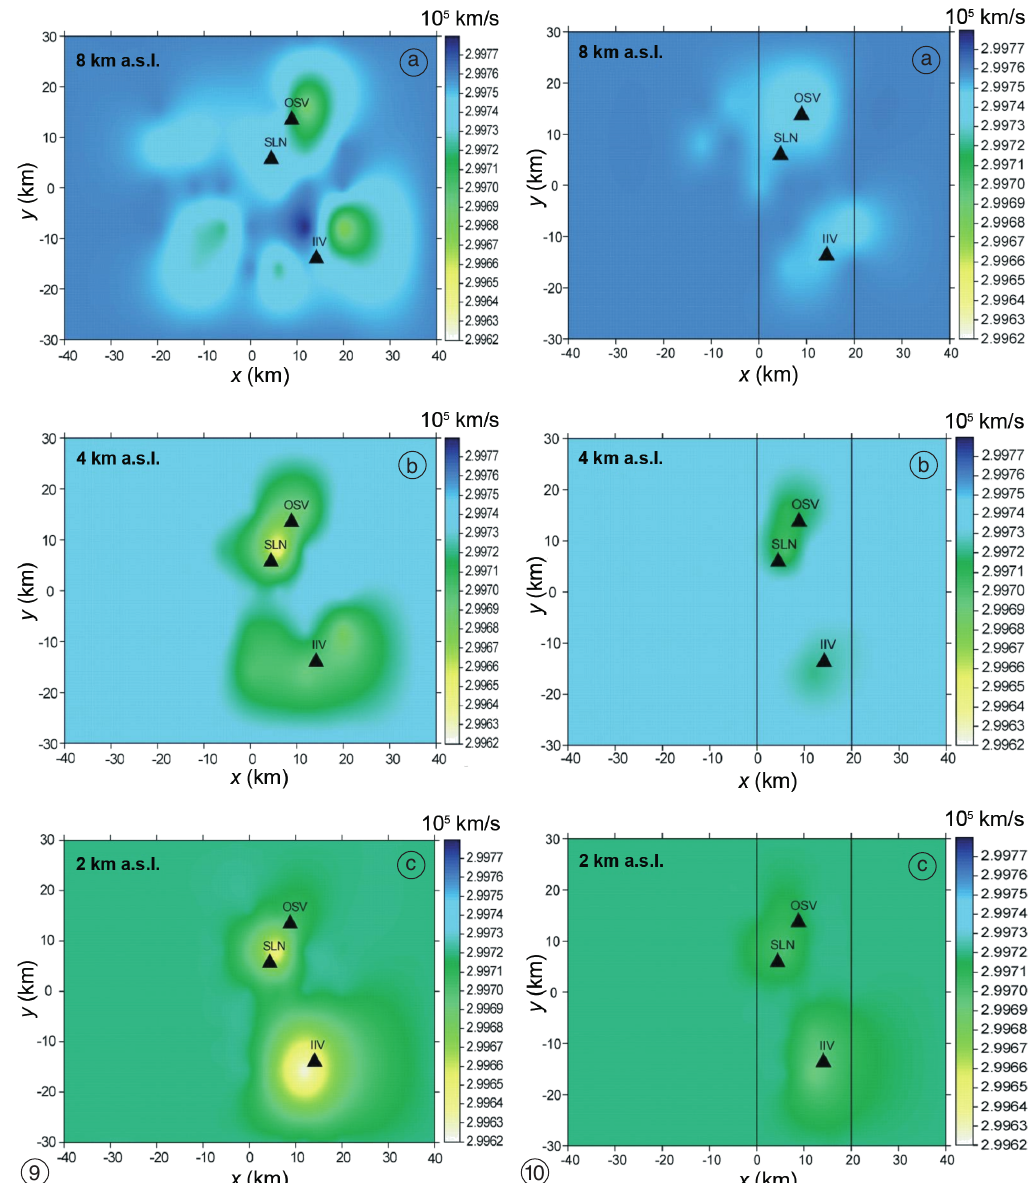
Fig. 9a-c. Radio waves velocity model obtained through tomographic inversion at horizontal planes placed re- spectively at the height of 8, 4 and 2 km a.s.l. Fig. 10a-c. Results of the resolution test for radio wave velocity model obtained through tomographic inver- sion at horizontal planes placed respectively at the height of 8, 4 and 2 km a.s.l. Vertical black lines indicate the zone where we have supposed there is the «atmospheric